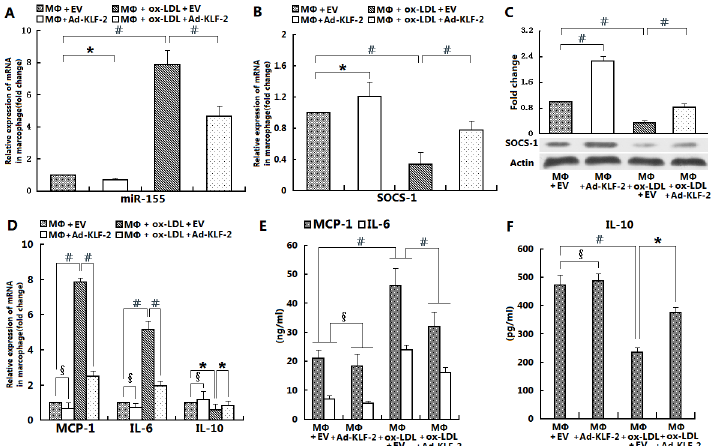
Fig 1. Ox-LDL-induced miR-155/SOCS-1 and pro-inflammatory responses in macrophages are regulated by KLF2 over-expression. The effects of KLF2 over-expression on miR-155 expression in macrophages (m ø ) cultured alone or activated by ox-LDL were examined. M ø from WT C57BL/6 mice were infected with either empty virus (EV) (as a control) or virus containing Ad-KLF2 for 24 – 48 h and then stimulated with ox-LDL (50 μ g/ml) for 24 h. Total RNA was extracted and subjected to RT-PCR analysis to determine miR-155 mRNA expression levels. Bar graphs indicate relative miR-155 mRNA levels normalized